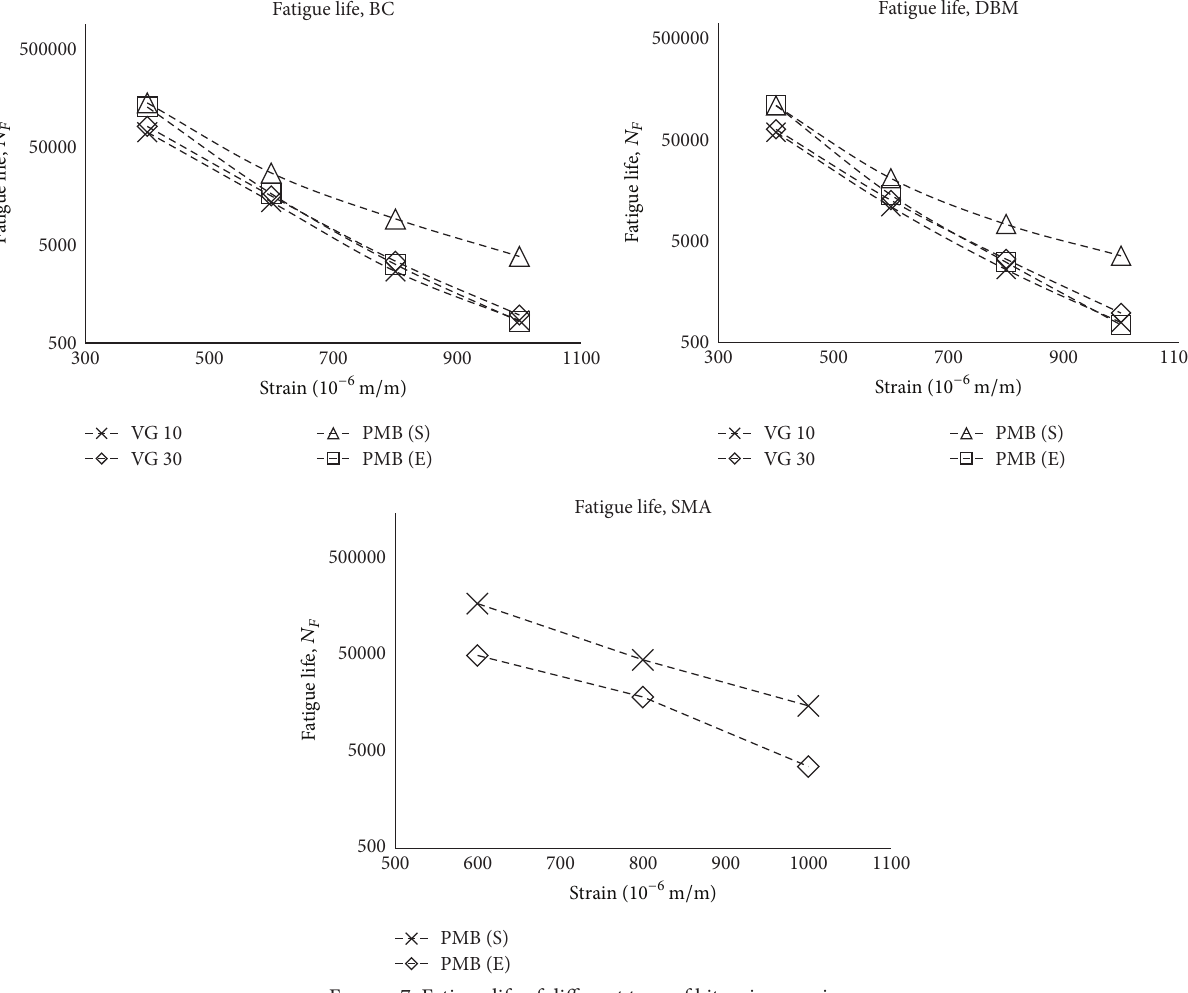
Figure 7: Fatigue life of different type of bituminous